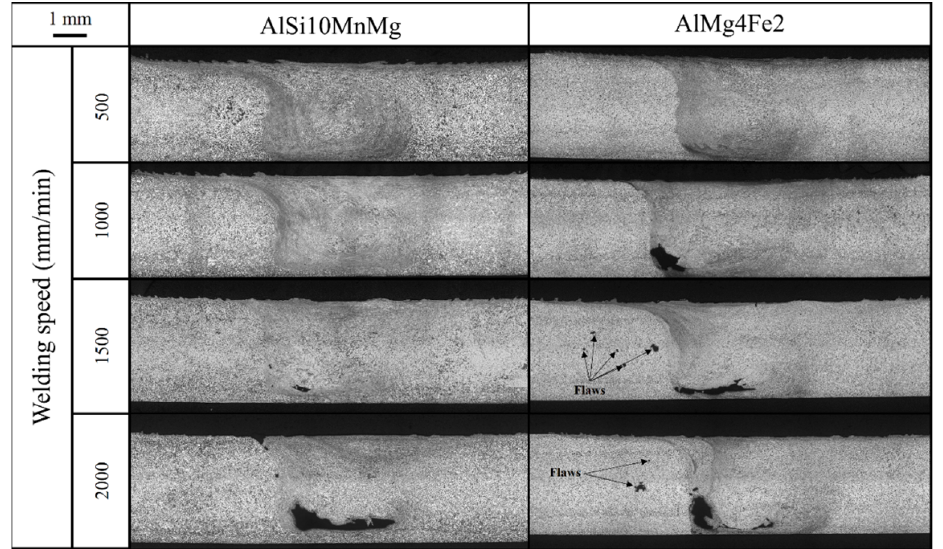
Figure 8. Macro sections of the AlSi10MnMg and AlMg4Fe2 welds. In each image the advancing side is on the left. Arrow marks indicate flaws produced during the VPDC process.